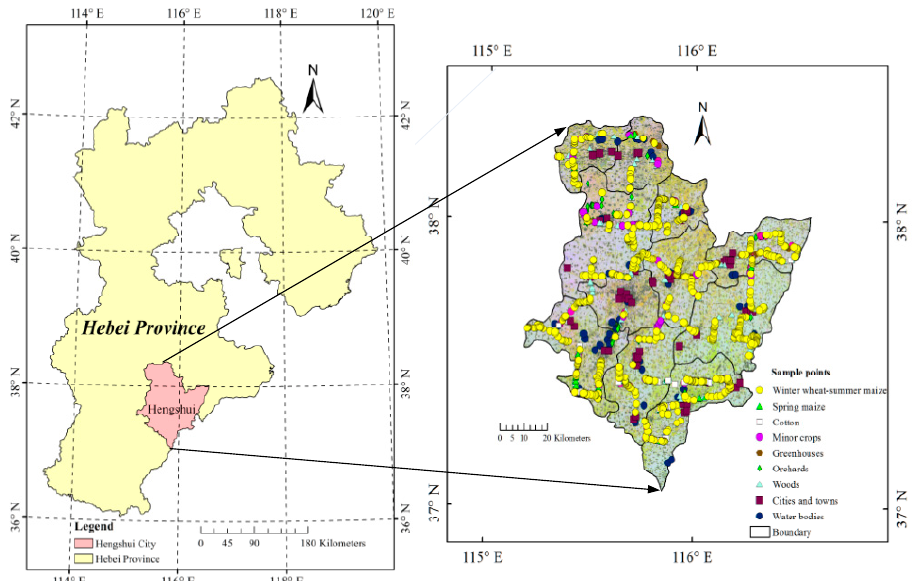
Figure 1. Geographical location and sample distribution of the study area.